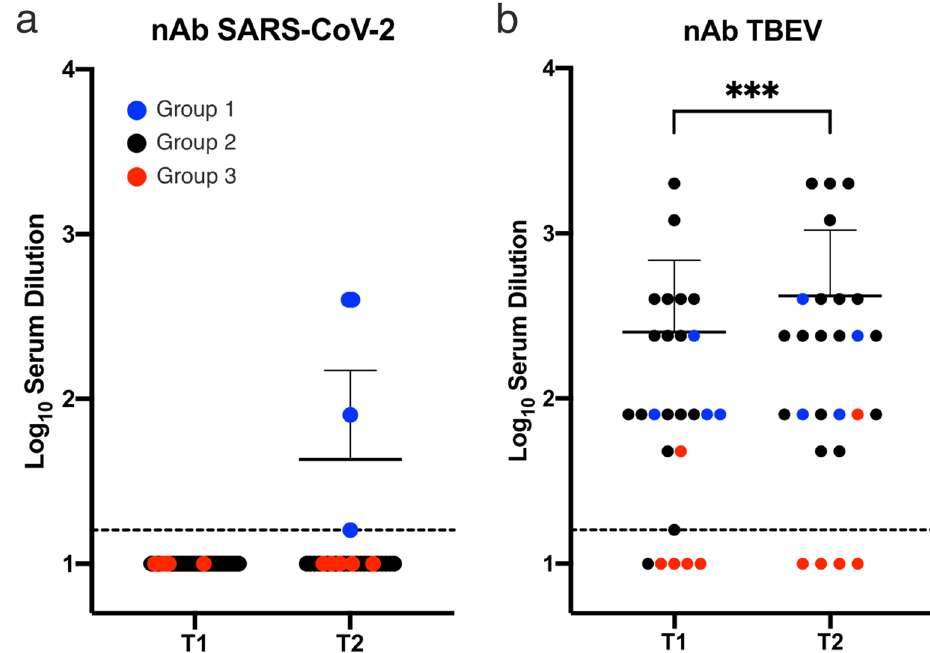
Figure 1. Serum neutralization test (SNT) revealed no cross-protection between SARS-CoV-2 and TBEV. ( a ) Neutralization against SARS-CoV-2 was only observed in convalescent patients (4/4, blue) and no cross- reactivity was observed in individuals vaccinated against TBEV (black). ( b ) Neutralization of TBEV was observed in almost all individuals vaccinated against TBEV at T1 (16/17, black) and increased significantly between sampling points (T2, 17/17); ***p = 0.001. Dashed line: Limit of detection, 1:16 serum dilution. Non- neutralizing samples are assigned the value 10. T1 March/April 2020, T2 August/September 2020, Group 1